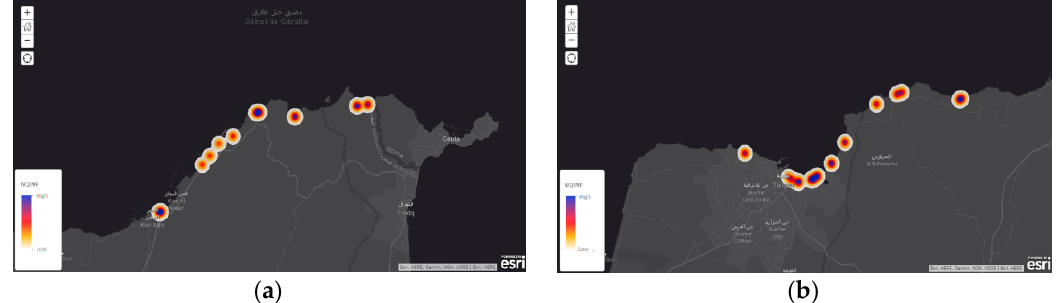
Figure 1. Classification of Water Quality Index in the study area. ( a ) Ksar Sghir region; ( b ) Tangier-Assilah